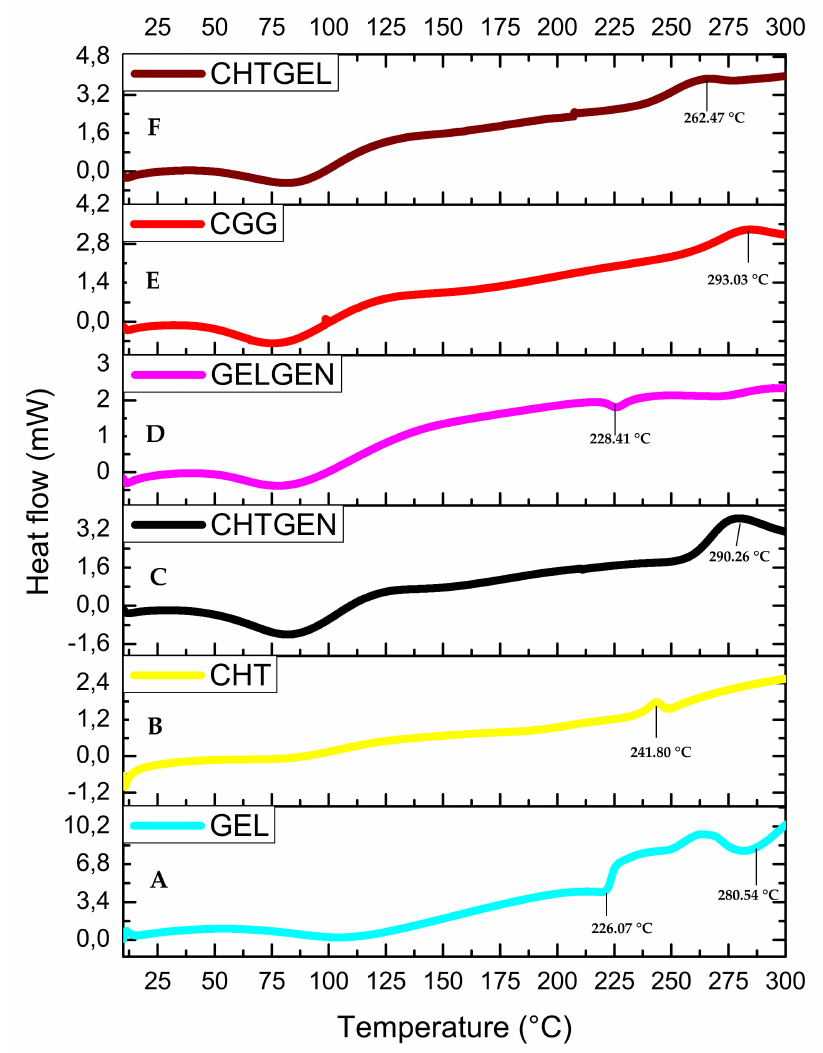
Figure 7. DSC thermograms of ( A ) GEL, ( B ) CHT, ( C ) CHTGEN, ( D ) GELGEN, ( E ) CGG and ( F )